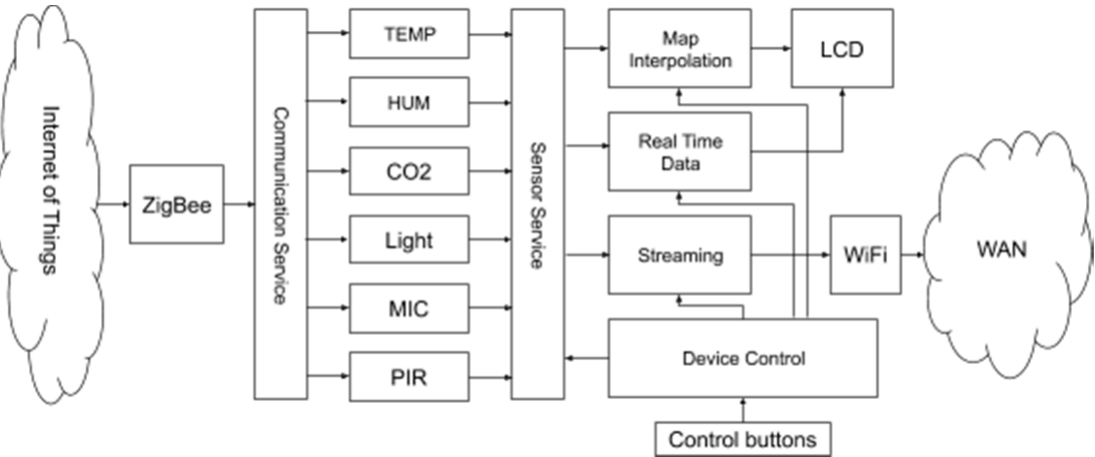
Figure 12. Functional & dataflow diagram for the IoT server coordinator.